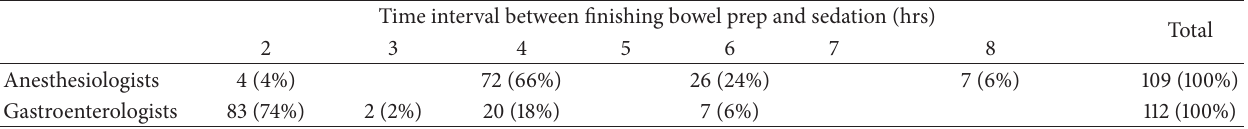
Table 1: Optimal time interval between bowel preparation and sedation.